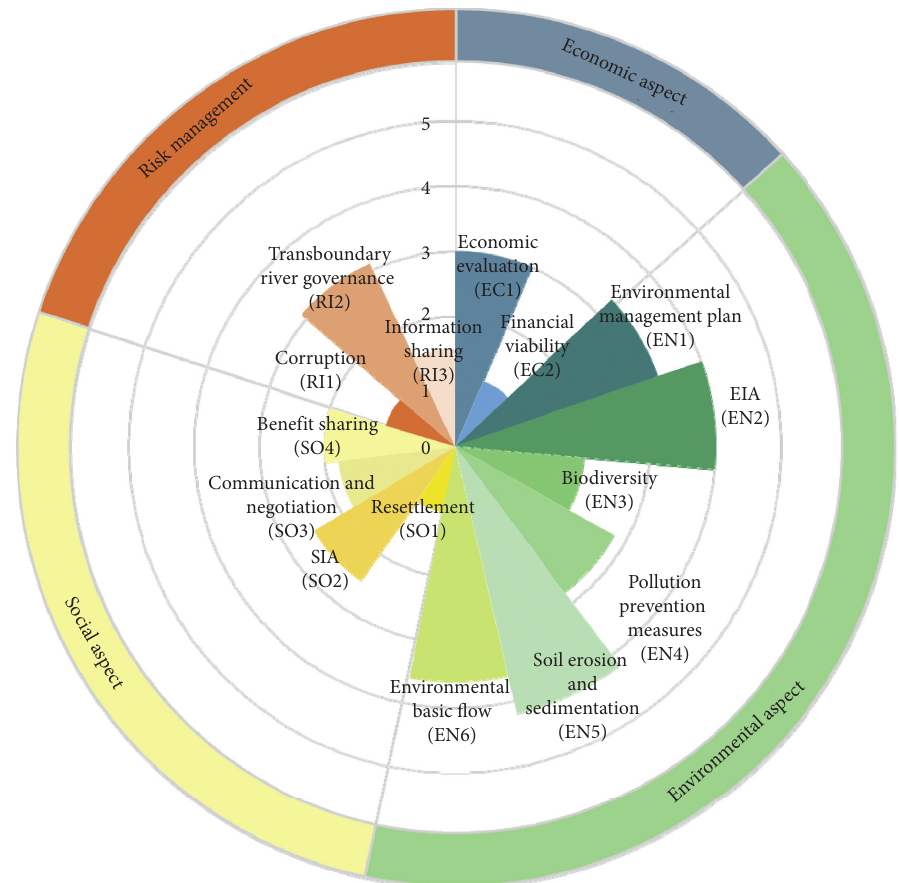
Figure 5: Sustainability assessment results of Rogun